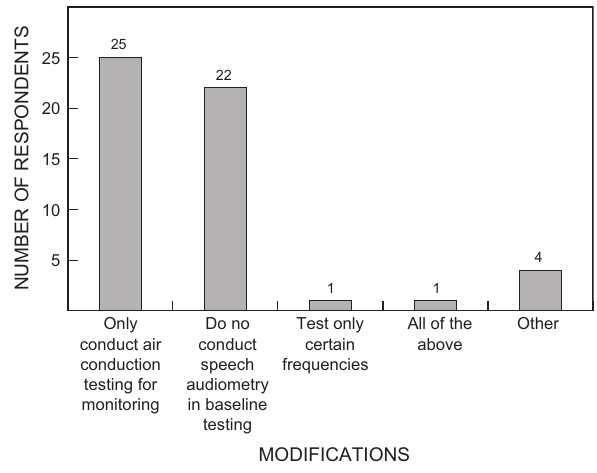
Figure 2: Modifications made to the international guidelines ( n = 42)